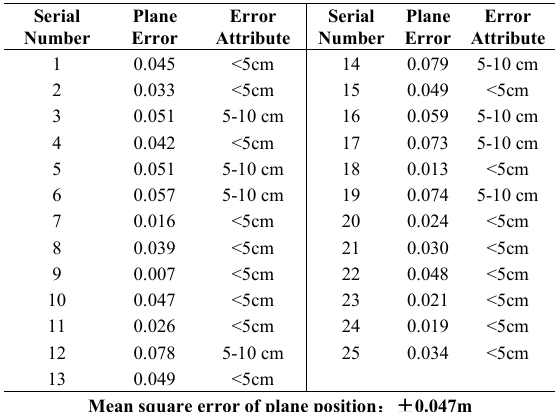
Figure 9 Measurement trajectory.